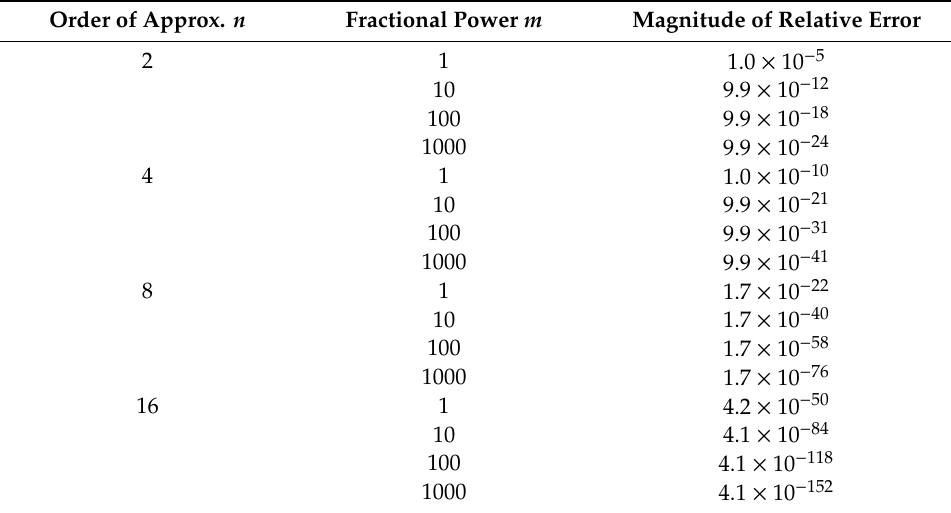
Table 5. Relative error in evaluation of e . Order of Approx. n